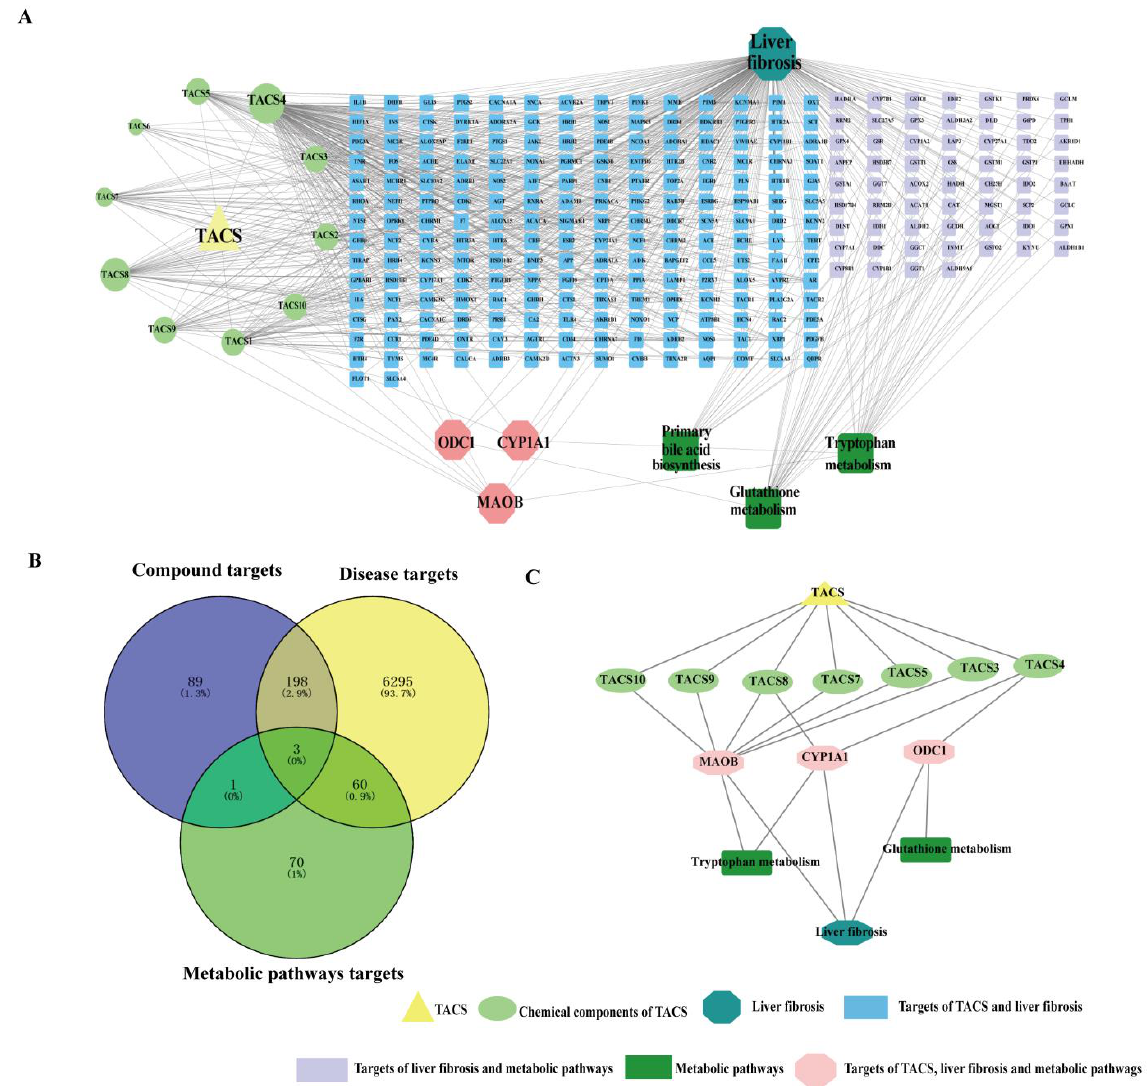
Figure 7. Network pharmacology prediction. ( A )The compound – target – pathway — disease net- work. ( B ) The compound – target – pathway — disease Venn ( C ) Active ingredient-corresponding tar- get – pathways – disease interaction network.